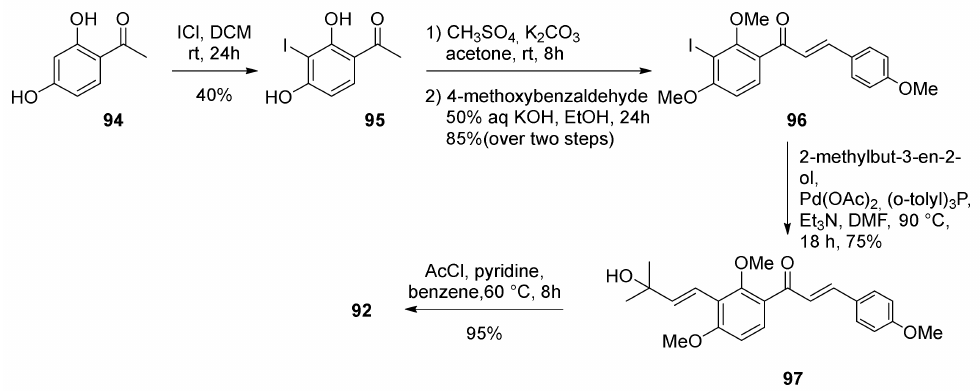
Figure 28. Synthesis of chalcone diene 92